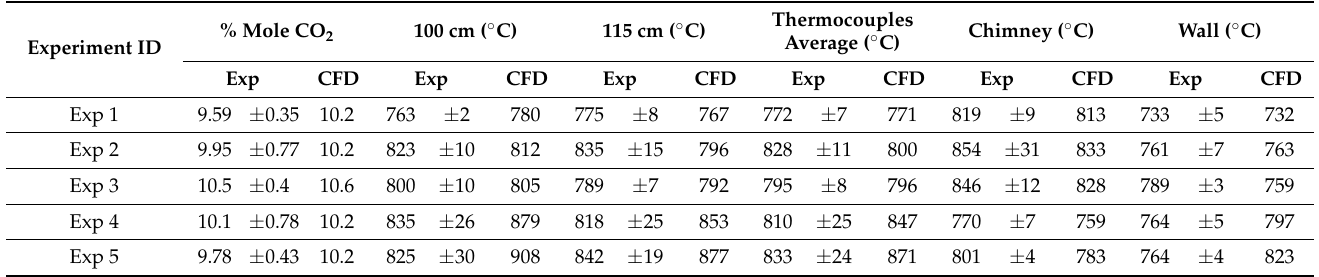
Table 4. Temperature and CO 2 composition measurement and calculation result